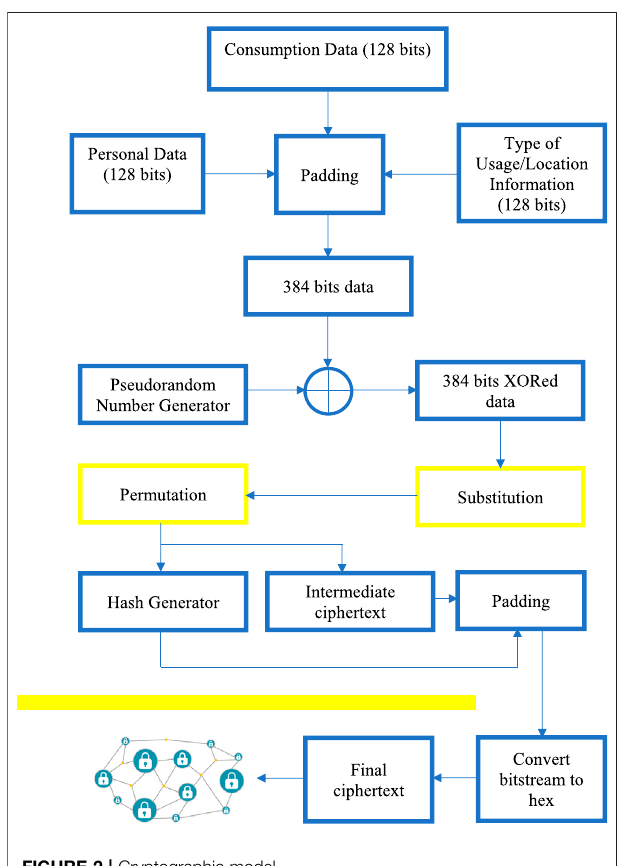
FIGURE 2 | Cryptographic